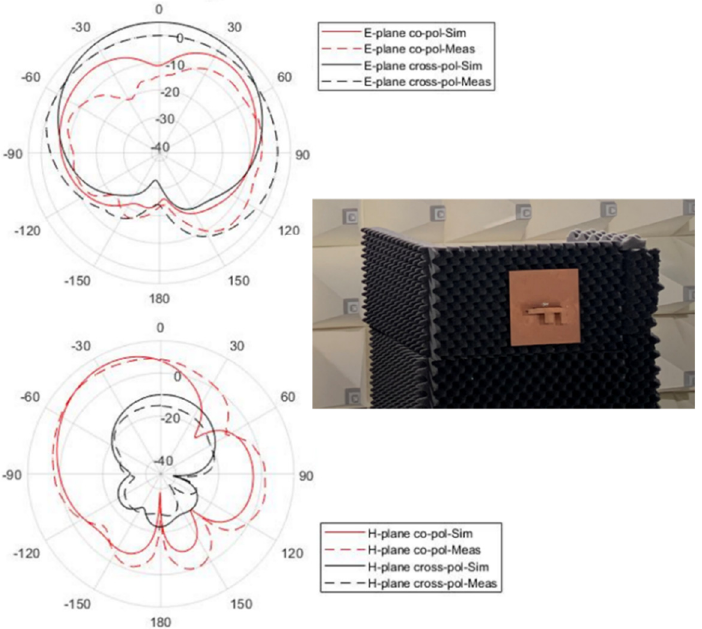
Figure 14. Measured and simulated radiation patterns in (top) x-z-plane (E-plane) and (bottom) y-z-plane (H-plane) at 2.45 GHz (inset: antenna under measurement).